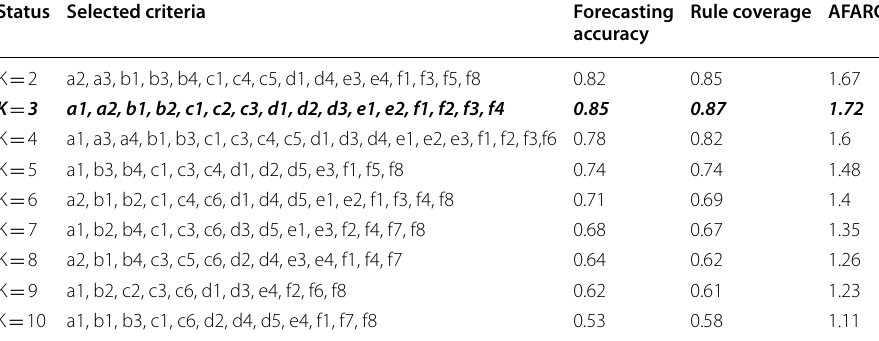
Table 3 The selected criteria by ACO-FRST Status Selected